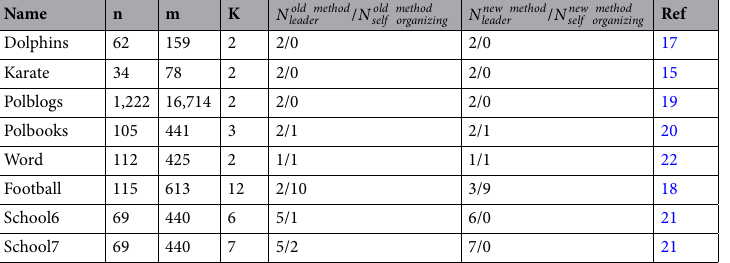
Table 1. Eight real networks with known community structures. In the table, n and m are the numbers of nodes and edges, respectively, and K is the number of communities in a network. N xy means the number of x community under method y, where x ∈ {leader, self organizing} and y ∈ {old method, new